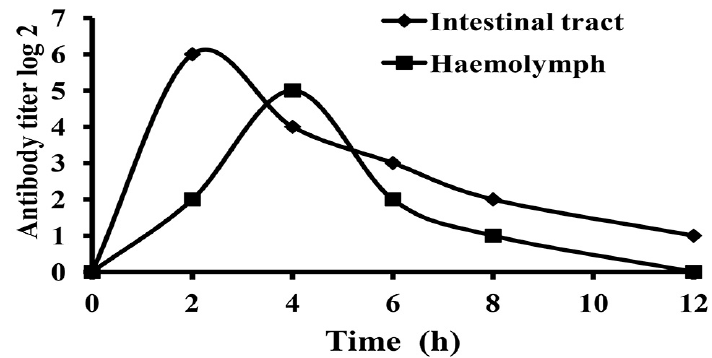
Figure 4. Different antibody levels in hemolymph and intestinal tract of Litopenaeus vannamei after oral administration the egg yolk powder by indirect ELISA.